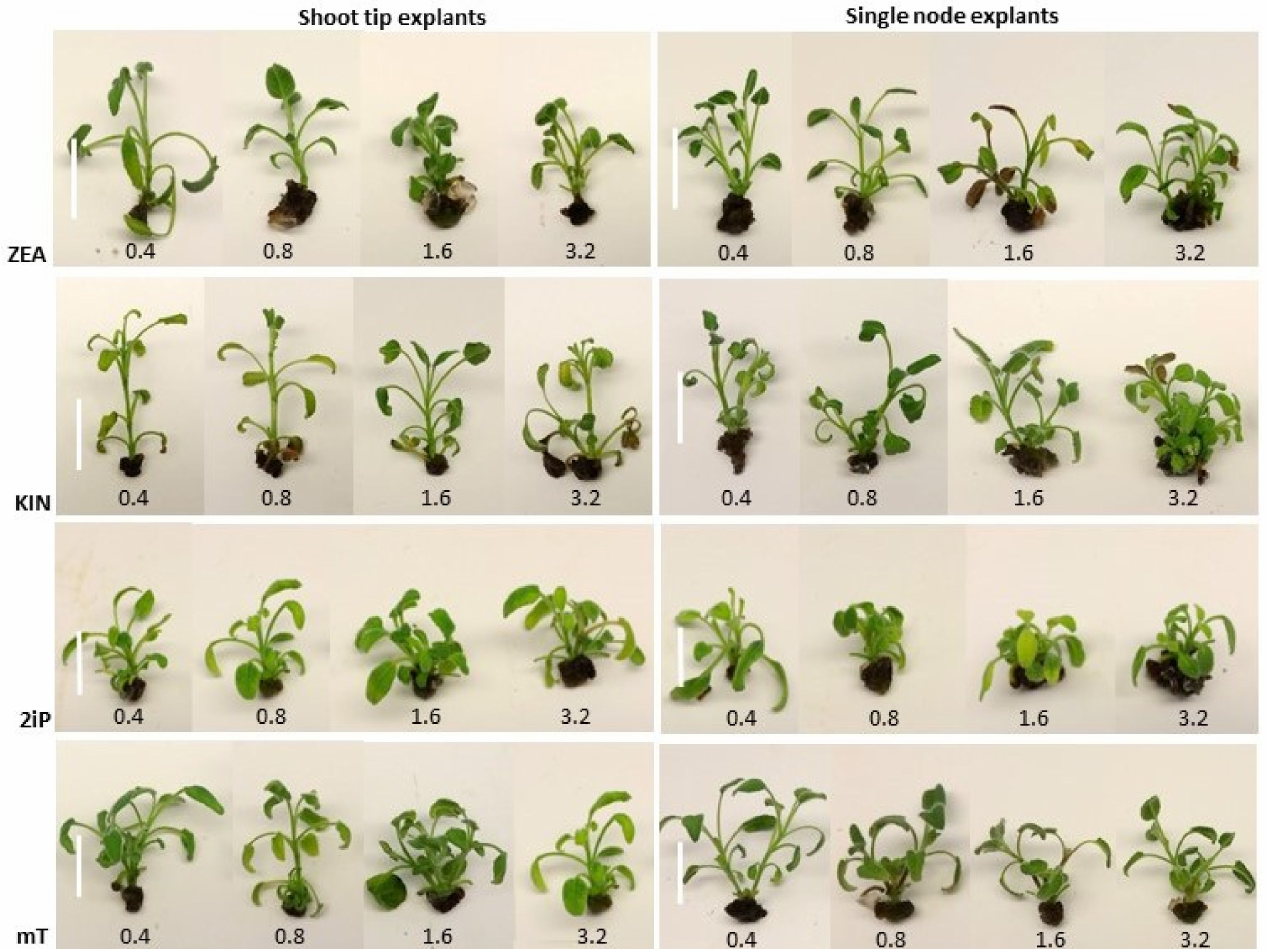
Figure 9. Characteristic shoot multiplication of shoot tip and single node explants of S. fruticosa cul- tured on MS medium supplemented with 0.01 NAA (mg.L − 1 ), and cytokinin type and concentration (mg.L − 1 ) marked. Size bars= 1.0